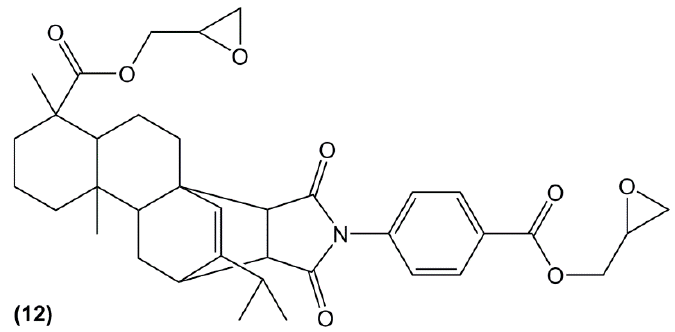
Figure 13. Chemical structure of a rosin-based diepoxy compound [139].